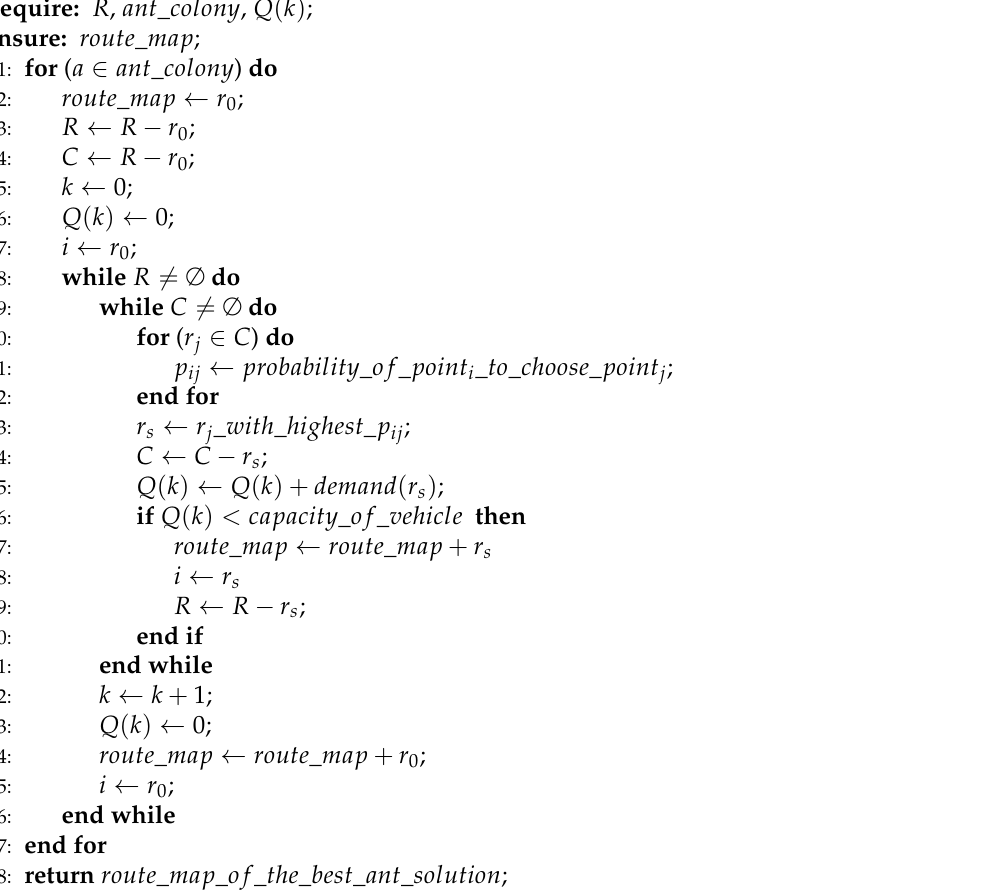
Algorithm 2 Routing and sequencing of the second